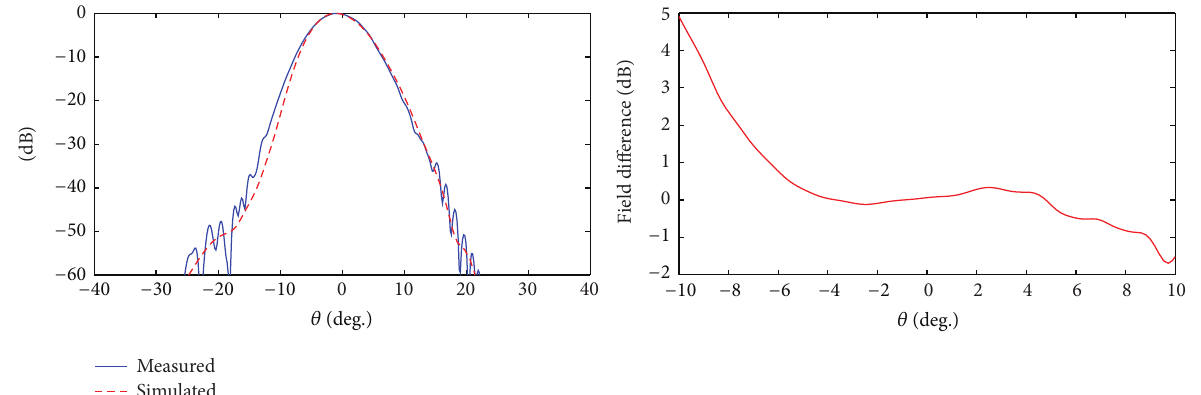
Figure 16: Calculated and simulated far field patterns of the 325 GHz channel on horizontal plane.